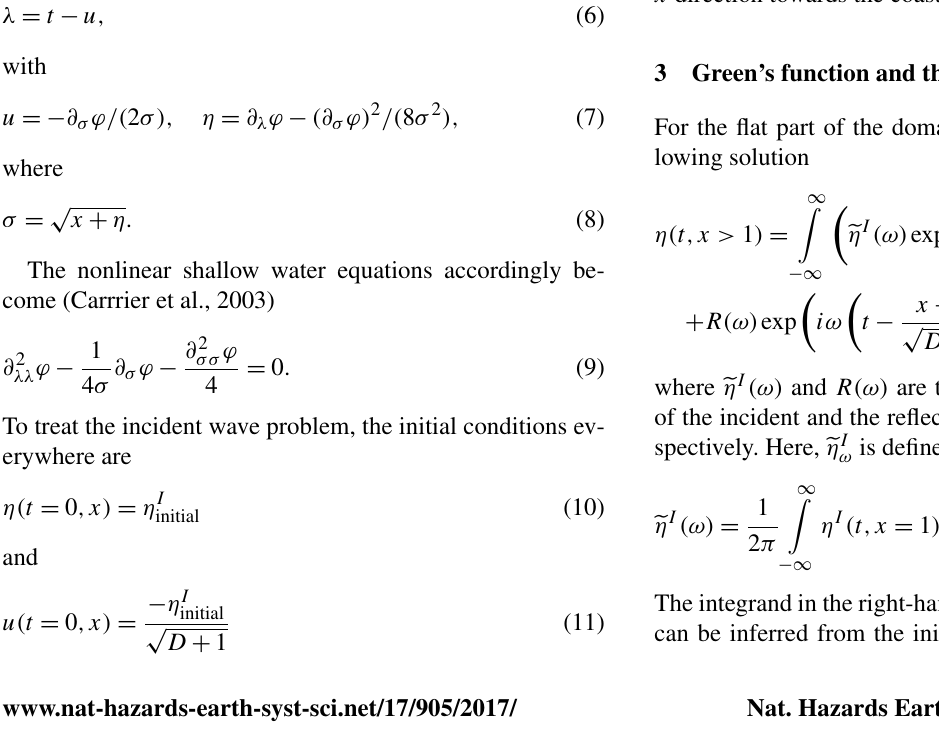
A hodograph transformation introduced by Carrrier et